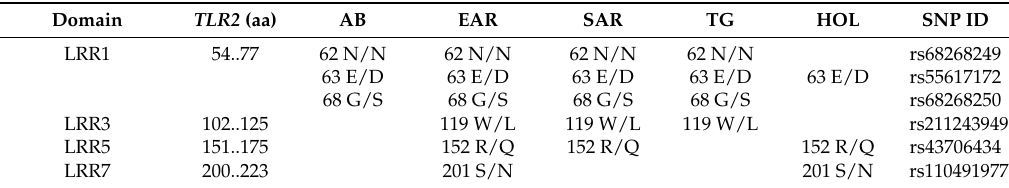
Table 3. Missense and synonymous variations on protein domain level of TLR2 (according to reference sequence NP_776622.1).